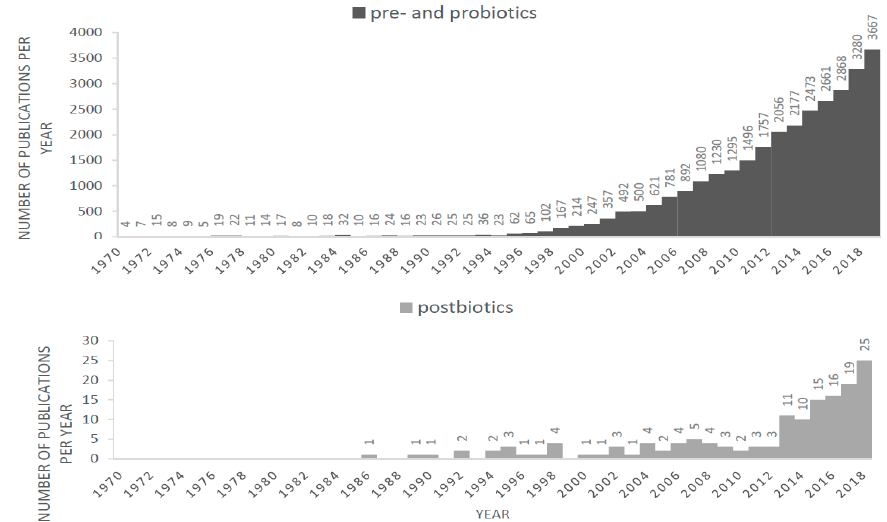
Figure 1. Comparison between the number of publications; on top the search of prebiotics and probiotics and below the search of postbiotics, paraprobiotics and fermented infant formulas (FIFs), and their synonyms in PubMed January 2019.